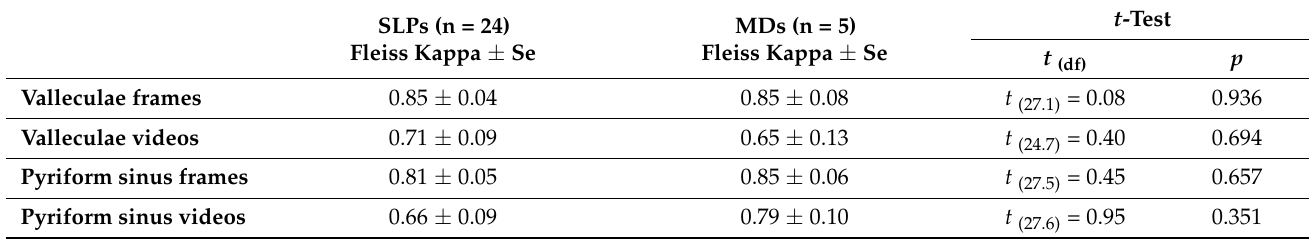
Table 8. Inter-rater in frames and videos rating across SLPs group and MDs